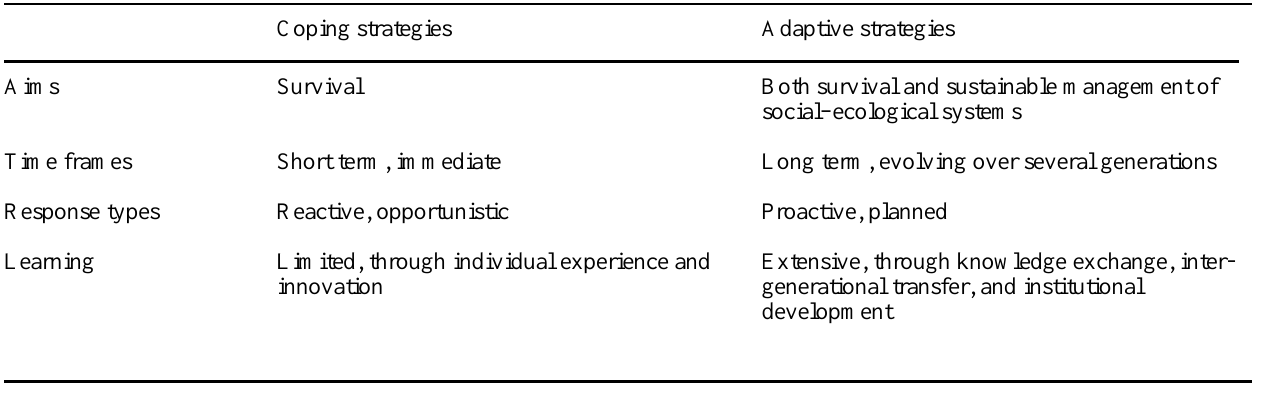
Table 1. The characteristics of coping and adaptive strategies in communities Coping strategies Adaptive